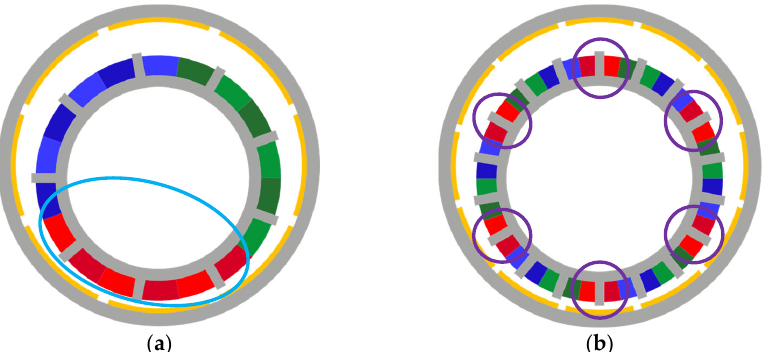
Figure 9. Schematics of ( a ) a 9-slot, 8-pole PMSM with conventional stator core subject to eccentricity. In this case, the phase windings form a single group of conductors (light blue oval) distributed in a specific part of the stator circumference and ( b ) an 18-slot, 12-pole PMSM with conventional stator core subject to eccentricity. In this case, the phase windings form six group of conductors (light blue oval) evenly distributed in the stator circumference, damping the potential back-emf